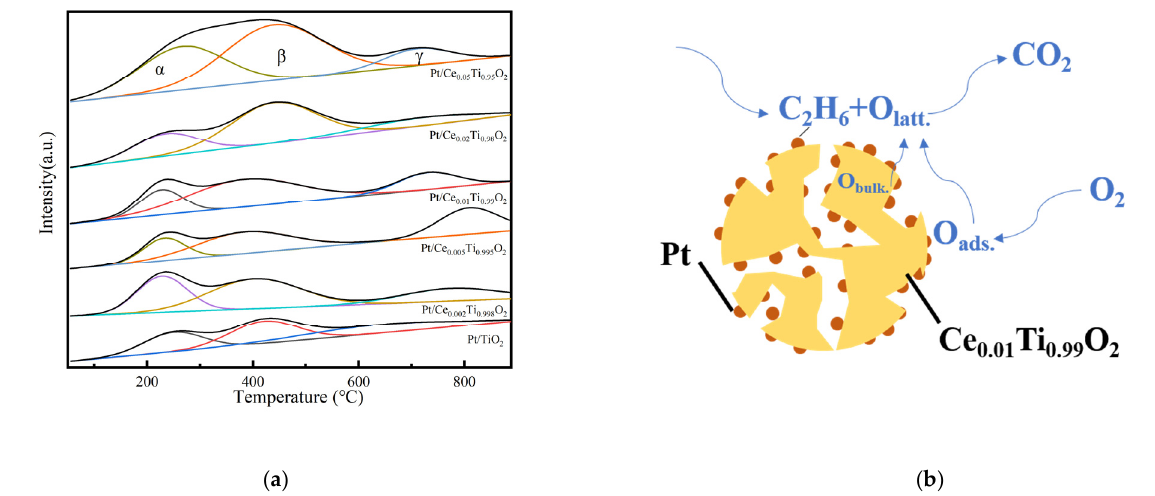
Figure 7. ( a ) O 2 -TPD profiles of Pt/Ce x Ti 1 − x O 2 (x = 0, 0.002, 0.005, 0.01, 0.02, and 0.05) catalysts. ( b ) Reaction mechanism section of the Pt/Ce 0.01 Ti 0.99 O 2 catalyst.